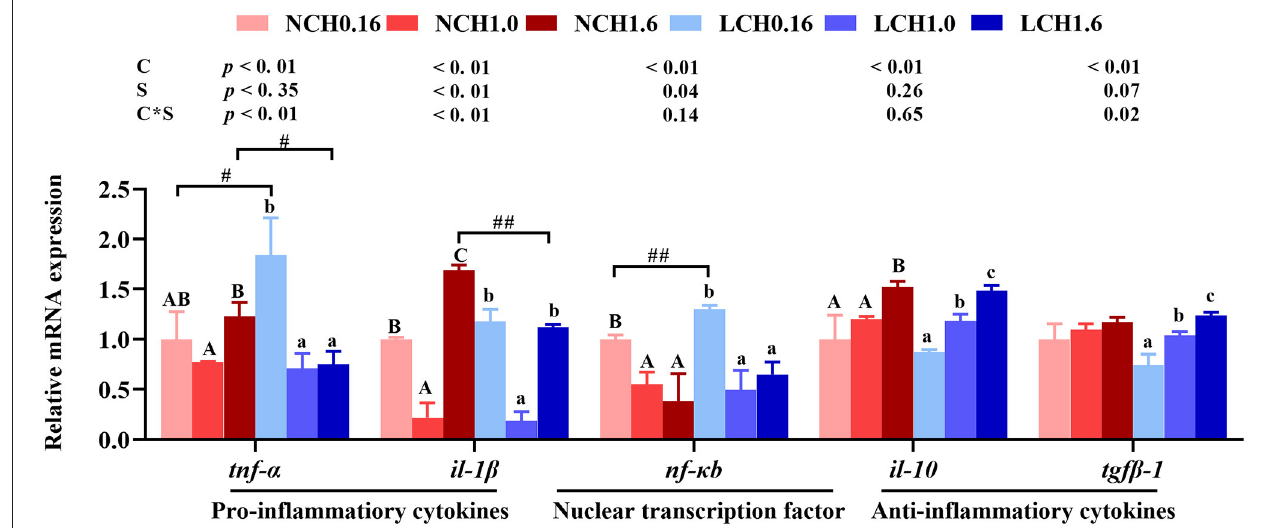
FIGURE 6 | Effects of dietary cholesterol level and water salinity on hepatic relative mRNA expression involved in inflammatory response in liver of juvenile Acanthopagrusschlegelii . The group of NCH0.16 was set as the reference group, and the mRNA expression levels of target genes were normalized relative to the expression of β -actin . Values are means ( n = 3) with standard errors represented by vertical bars. Two-way ANOVA P -values are shown in each panel, with “C” representing effects of dietary cholesterol levels, “S” representing effects of salinity, and “C*D” representing interaction between dietary cholesterol levels and salinity. “ABC” representing significant ( P < 0.05) difference between dietary cholesterol levels in normal water salinity (23 psu) and “abc” representing significant ( P < 0.05) difference between dietary cholesterol levels in low water salinity (5 psu) by performing one-way ANOVA. “#” representing significant ( P < 0.05) difference between